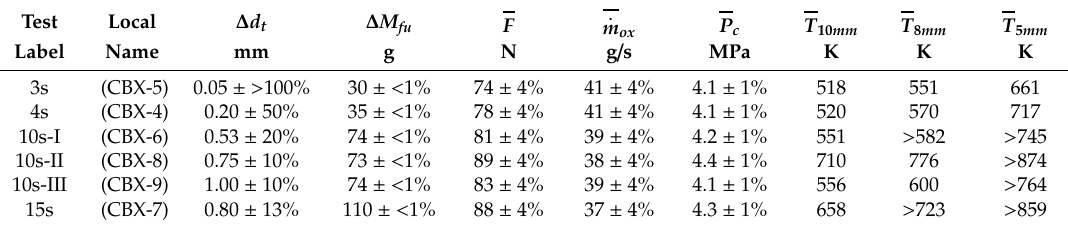
Table 1. Summary of direct measurements and their